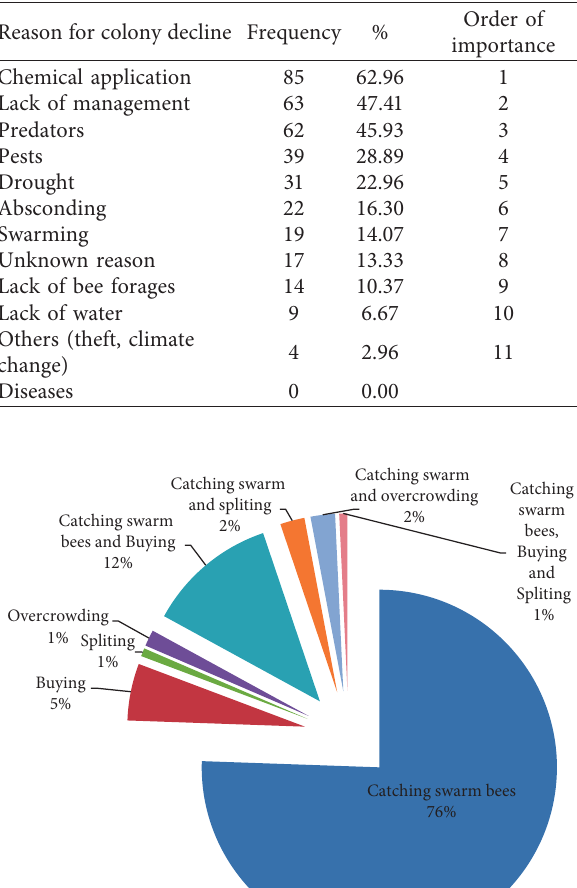
Table 4: Reasons of colony decline.